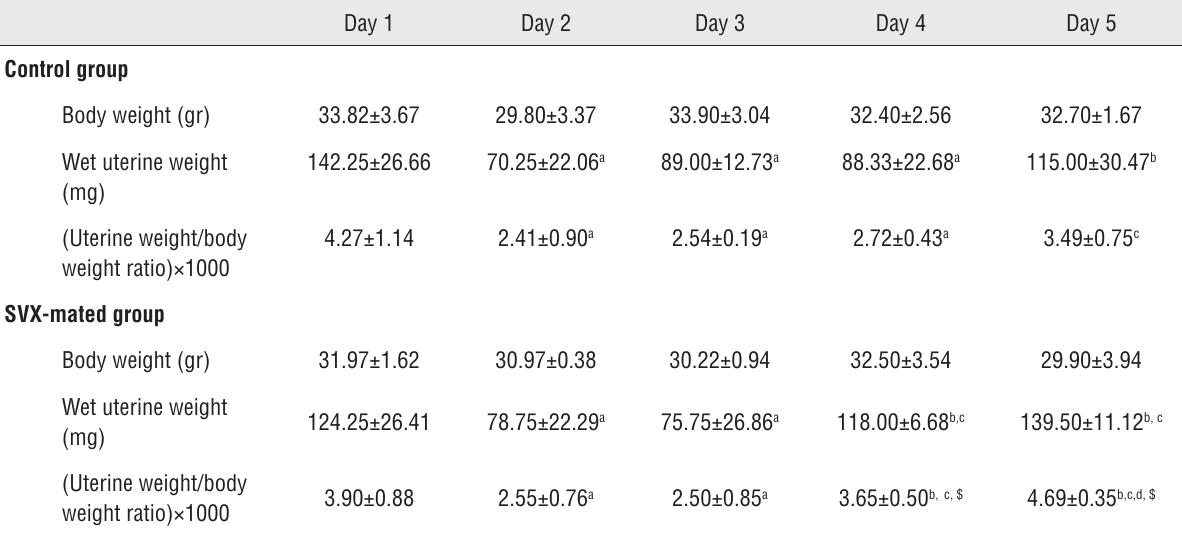
Table 2 - Animals and their wet uterine weight as well as uterine weight/body weight ratio on various pregnancy days in control (n=20) and seminal vesicle excised (SVX)-mated (n=20)